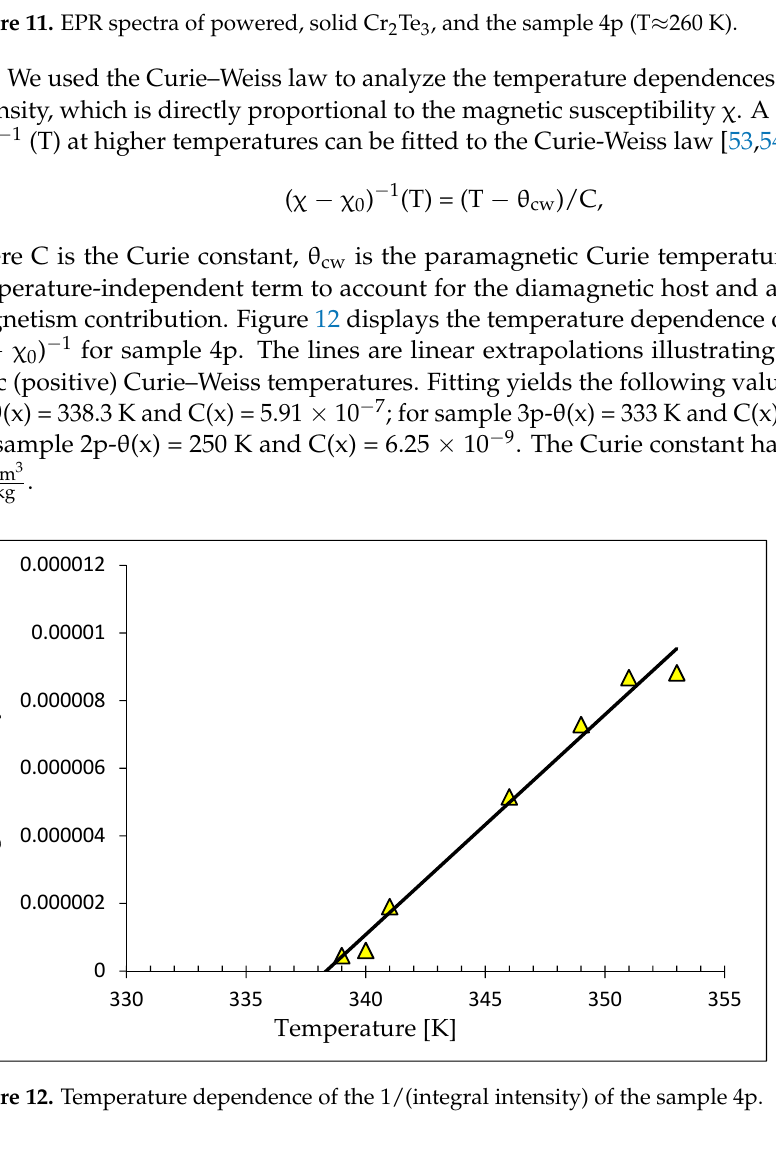
temperature T C = 338.3 K for sample 4pg e values for the samples 3p, 4p, and 5p show